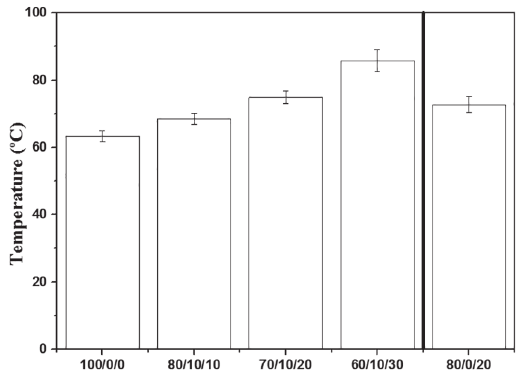
Figure 7: Shore D hardness testing results.